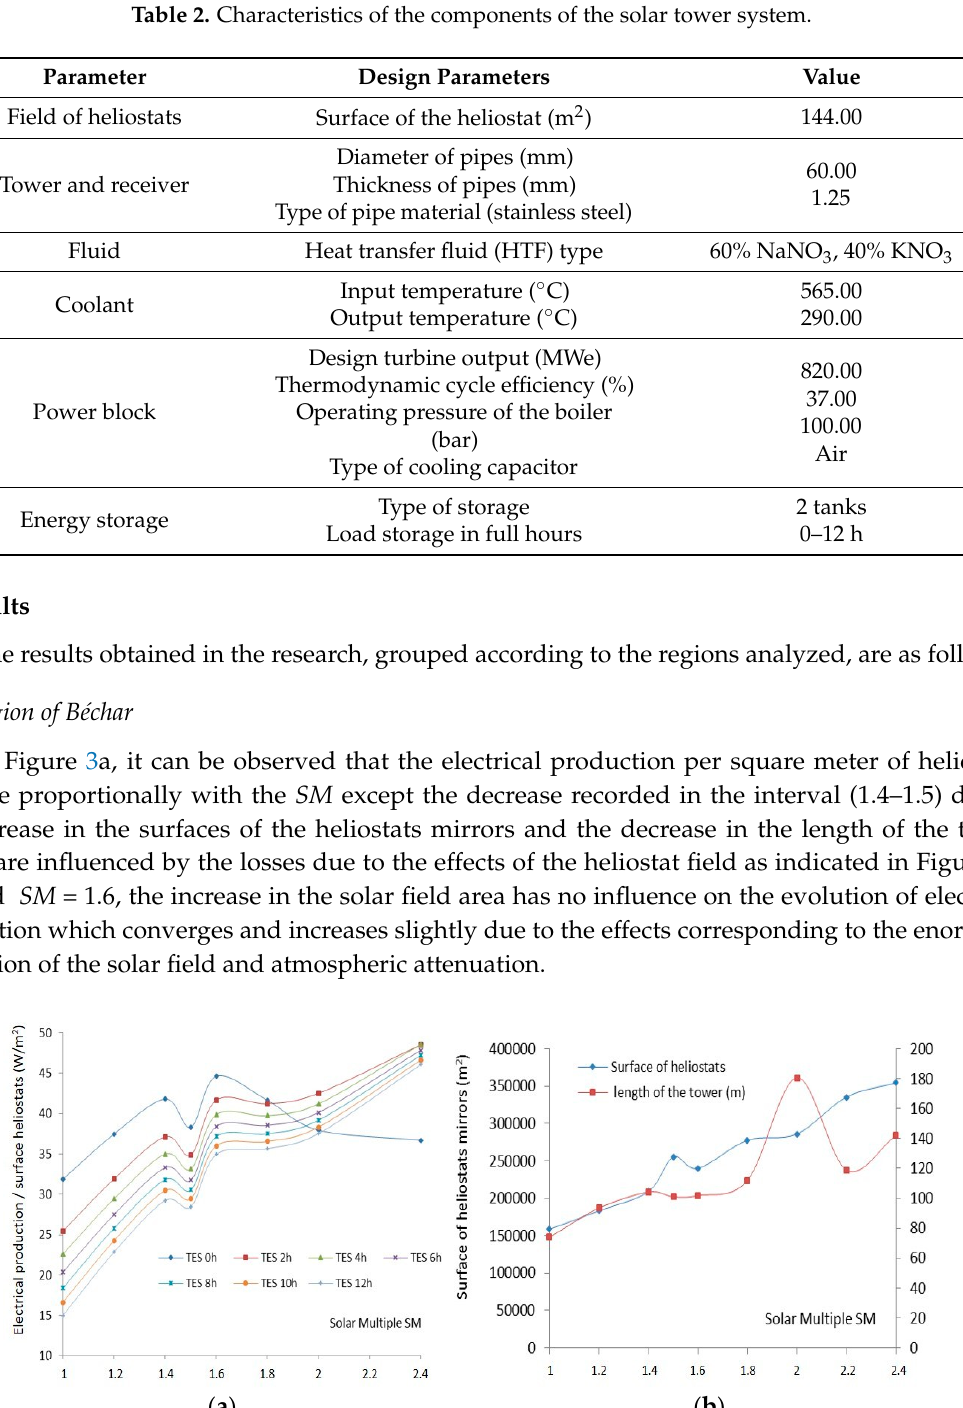
Table 2. Characteristics of the components of the solar tower system.